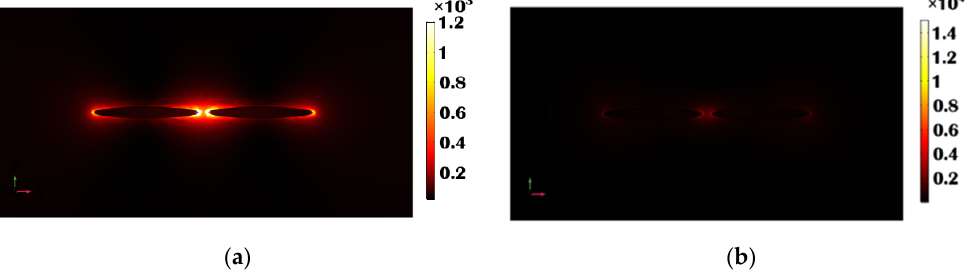
Figure 5. ( a ) E x , mode field profile at 940 nm wavelength in the x-y plane of a single metallic elliptical nano structure when a = 100 nm, b = 10 nm, and h = 100 nm, where a slice of the horizontal plane is placed at z = 100 nm. ( b ) The electric field profile at the 1000 nm wavelength in the x-y plane for a 10 layered LiTaO 3 stacked nano structure when a = 100 nm, b = 10 nm, and h 1 = h 2 = 10 nm, where the slice of the horizontal plane is adjusted at z = 100